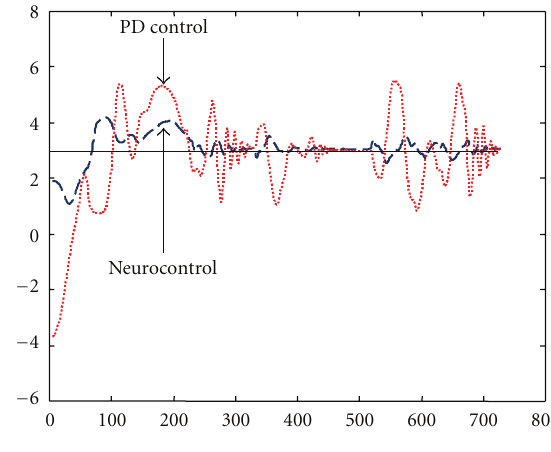
Figure 6: Tracking control of θ 1 (method D).